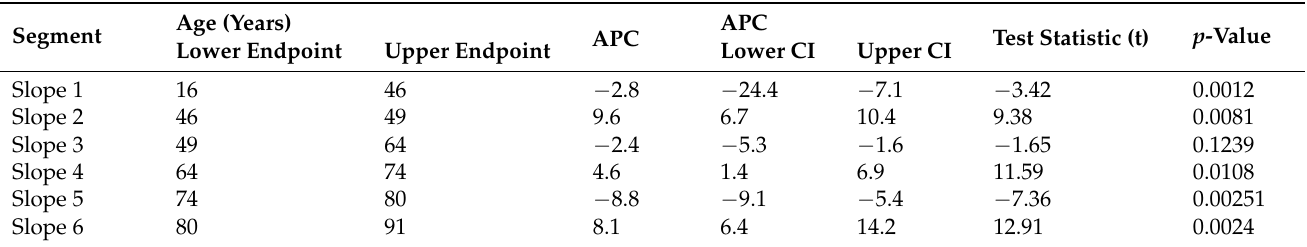
Table 2. APC—Annual percentage change for regression slopes of patient age and incidence of oral mucosa